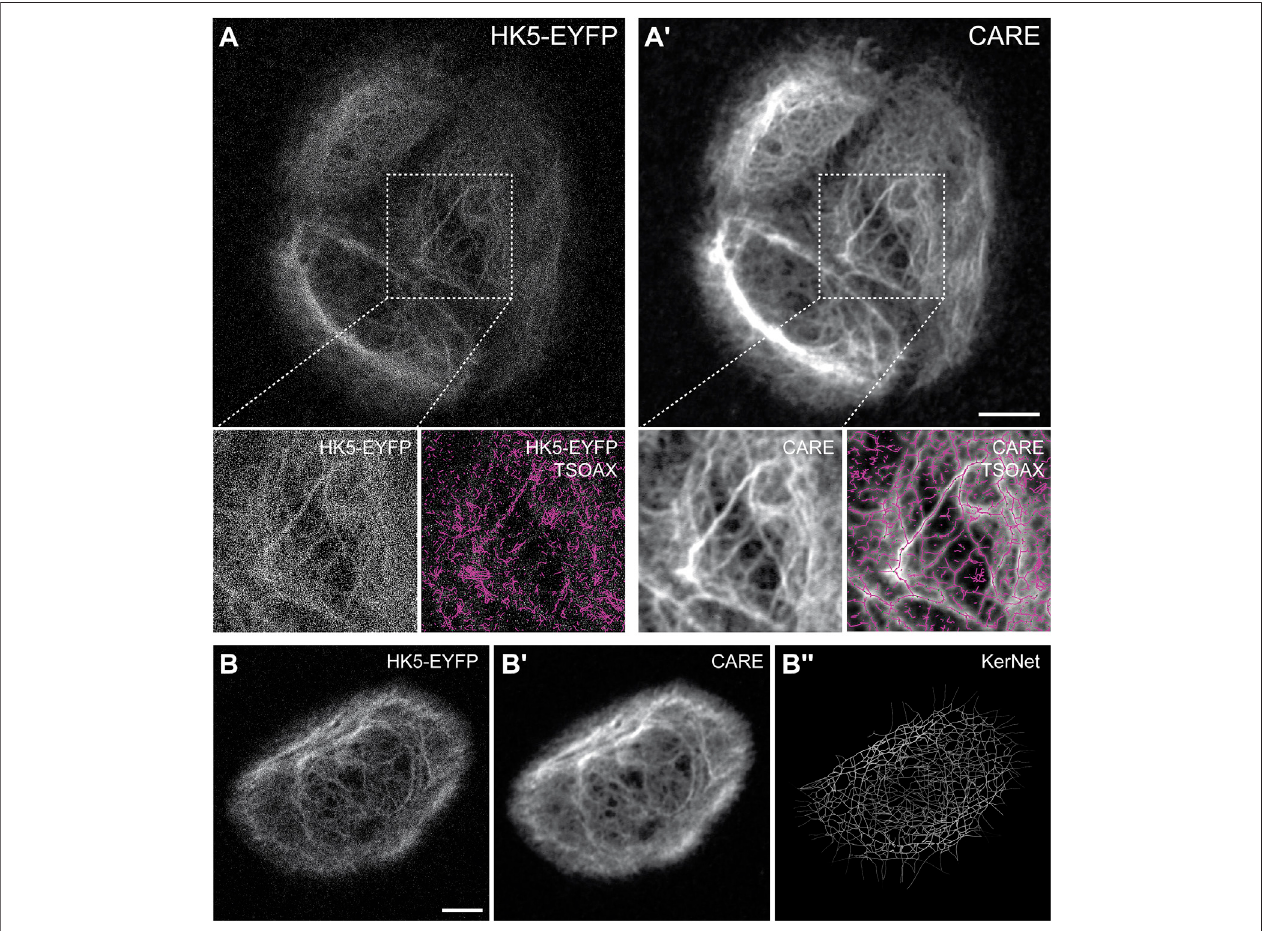
FIGURE 3 | Keratin fi lament network extraction performance is greatly enhanced for restored images. (A,A ’ ) The example shows the raw microscopic recording data (projection view of 20 slices) of the EYFP-tagged keratin 5 (HK5-EYFP) in HaCaT B10 cells (A) next to the restored data using CARE (A ’ ) . Note that this results in drasticallyimprovedKFnetworksegmentation(boxedarea).ThenetworksegmentationwasdonewiththehelpofTSOAXusingthesameparametersforbothdatasets. (B-B ’’ ) ShowsanexampleofarawmaximumintensityprojectionimagestackofHK5-EYFP fl uorescencerecordinginasingleHaCaTB10keratinocytegrowingon a D-shaped fi bronectin-coated micropattern (left). The restored image is shown in the center and the extracted 3D representation of segmented fi laments at right. Scale bars: 10 μ m.